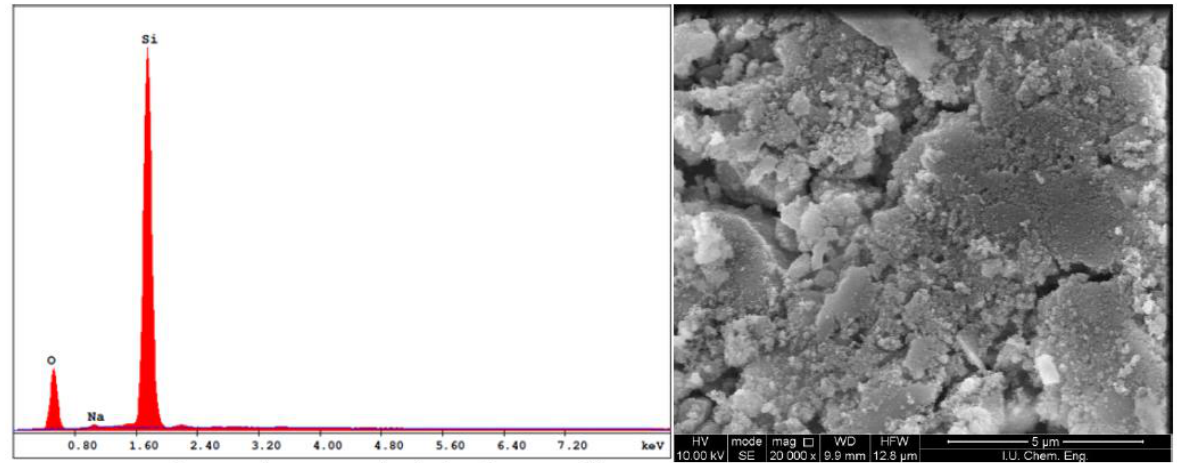
Figure 2. SEM photo and analysis for the nano silica particles.